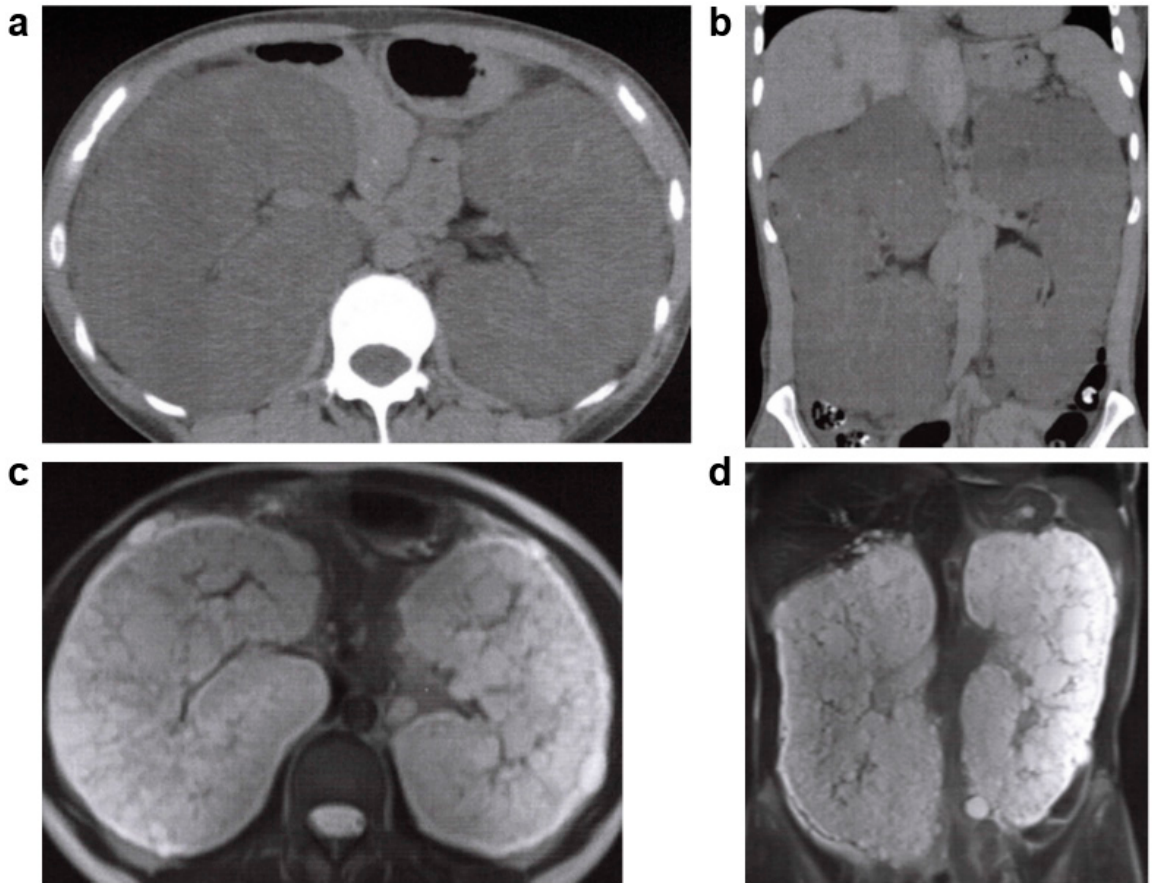
Figure 10. Oral-facial-digital syndrome (OFD) type 1: 30s, female, OFD1 gene heterozygous mutation, no family history of polycystic kidney disease or end-stage kidney disease, no history of hepatic cysts, cerebral aneurysm, or heart valve disease, no abnormalities in urinalysis, began dialysis at age 26 years (image provided by Toranomon Hospital). ( a ) Non-contrast CT image (horizontal section): multiple low-density cystic lesions are in both kidneys, accompanied by kidney enlargement. There is no change in the external appearance of the kidneys. ( b ) Non-contrast CT image (coronal section): multiple low-density cystic lesions are in both kidneys, accompanied by kidney enlargement. There is no change in the external appearance of the kidneys. ( c ) MRI T2-weighted image (horizontal section): multiple hyperintense cystic lesions are in both kidneys, accompanied by kidney enlargement. There is no change in the external appearance of the kidneys. ( d ) MRI T2-weighted image (coronal section): multiple hyperintense cystic lesions are in both kidneys, accompanied by kidney enlargement. There is no change in the external appearance of the kidneys.